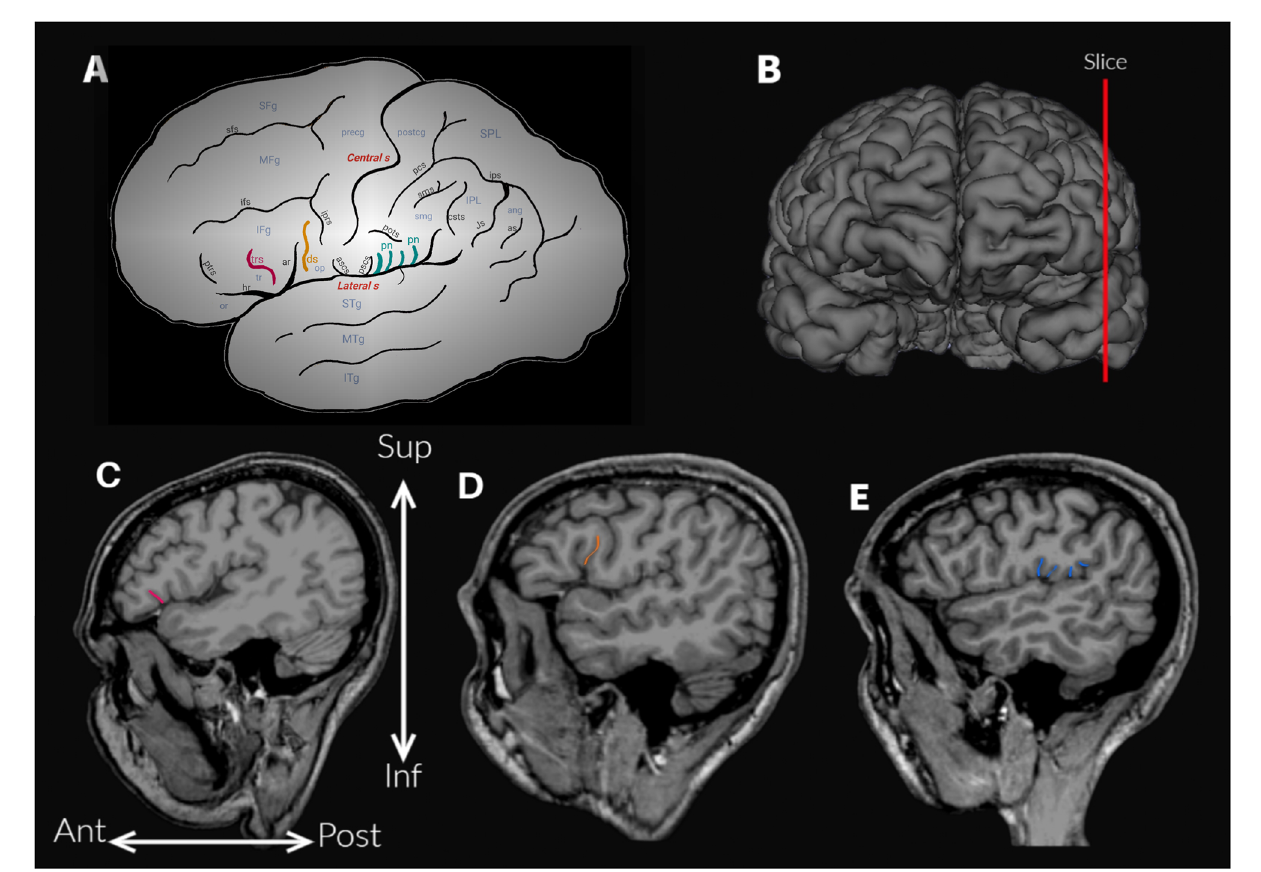
FIGURE1 (A) Schematic outline of the lateral surface of the hemisphere to illustrate the sulci and gyri of the frontoparietal operculum. Abbreviations: ar, ascending anterior ramus of the lateral sulcus; ang, angular gyrus; ans, angular sulcus; ascs, anterior subcentral sulcus; csts, caudal superior temporal sulcus; ds, diagonal sulcus (drawn in orange); hr, horizontal ramus of the lateral sulcus; IFg, inferior frontal gyrus; ifs, inferior frontal sulcus; IPL, inferior parietal lobule; iprs, inferior precentral sulcus; ips, intraparietal sulcus; ITg, inferior temporal gyrus; Js, Jensen sulcus; MFg, middle frontal gyrus; MTg, middle temporal gyrus; op, opercular part (or pars opercularis) of the inferior frontal gyrus; or, orbital part (or pars orbitalis) of the inferior frontal gyrus; pn, parietal notches of the lateral sulcus (drawn in light blue); pcs, postcentral sulcus; postg, postcentral gyrus; pots, postcentral transverse sulcus; precg, precentral gyrus; prts, pretriangular sulcus; pscs, posterior subcentral sulcus; SFg, superior frontal gyrus; sfs, superior frontal sulcus; smg, supramarginal gyrus; sms, supramarginal sulcus; SPL, superior parietal lobule; sps, superior parietal sulcus; STg, superior temporal gyrus; tr, triangular part (or pars triangularis) of the inferior frontal gyrus; trs, triangular sulcus (drawn in pink). (B) Approximate location of the parasagittal slices analyzed to assess the accessory sulci. (C) Triangular sulcus. (D) Diagonal sulcus. (E) Parietal notches.